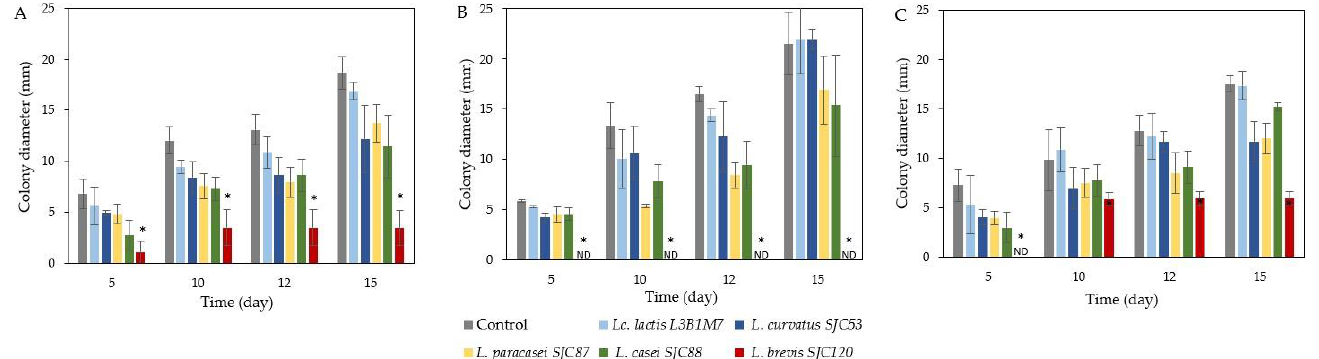
Figure 1. Effect of whey – gelatin films incorporated with Lc. lactis L3B1M7, L. curvatus SJC53, L. paracasei SJC87, L. casei SJC88, and L. brevis SJC120 on fungal growth (mm) of ( A ) P. brevicompactum , ( B ) P. commune , and ( C ) P. nordicum for 15 days at 10 °C. Values are the mean ± SEM ( n = 3). * p < 0.05 versus control. ND: not detected (no fungal growth observed).